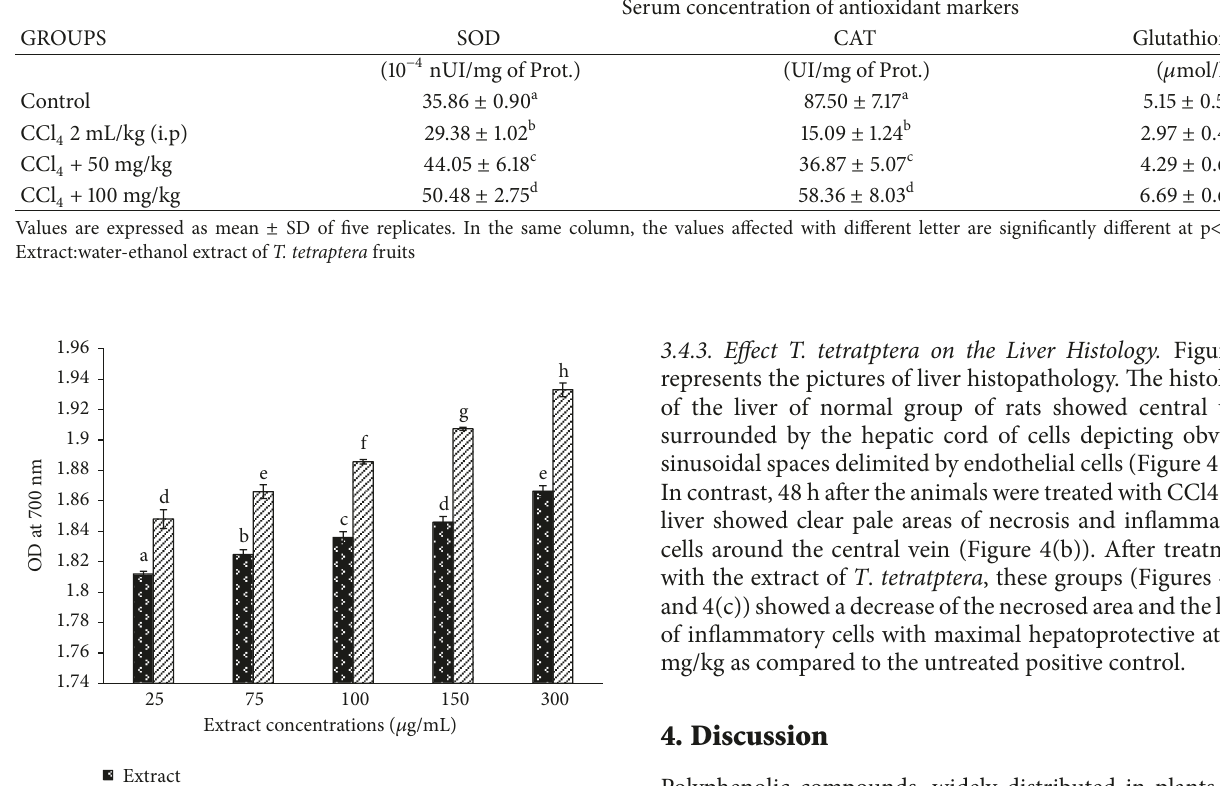
Table 3: Effect of the water-ethanol extract of Tetrapleura tetraptera on some antioxidant markers in vivo . Serum concentration of antioxidant markers